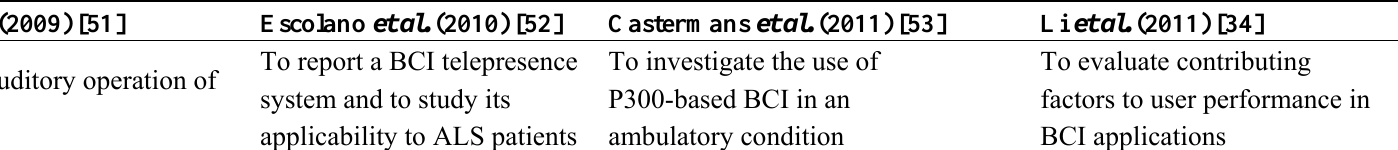
Table 2. Studies selected for